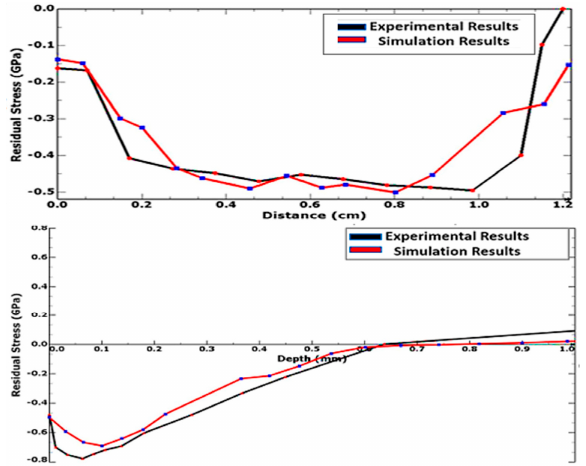
Figure 9. Numerical vs. experimental results benchmarking.